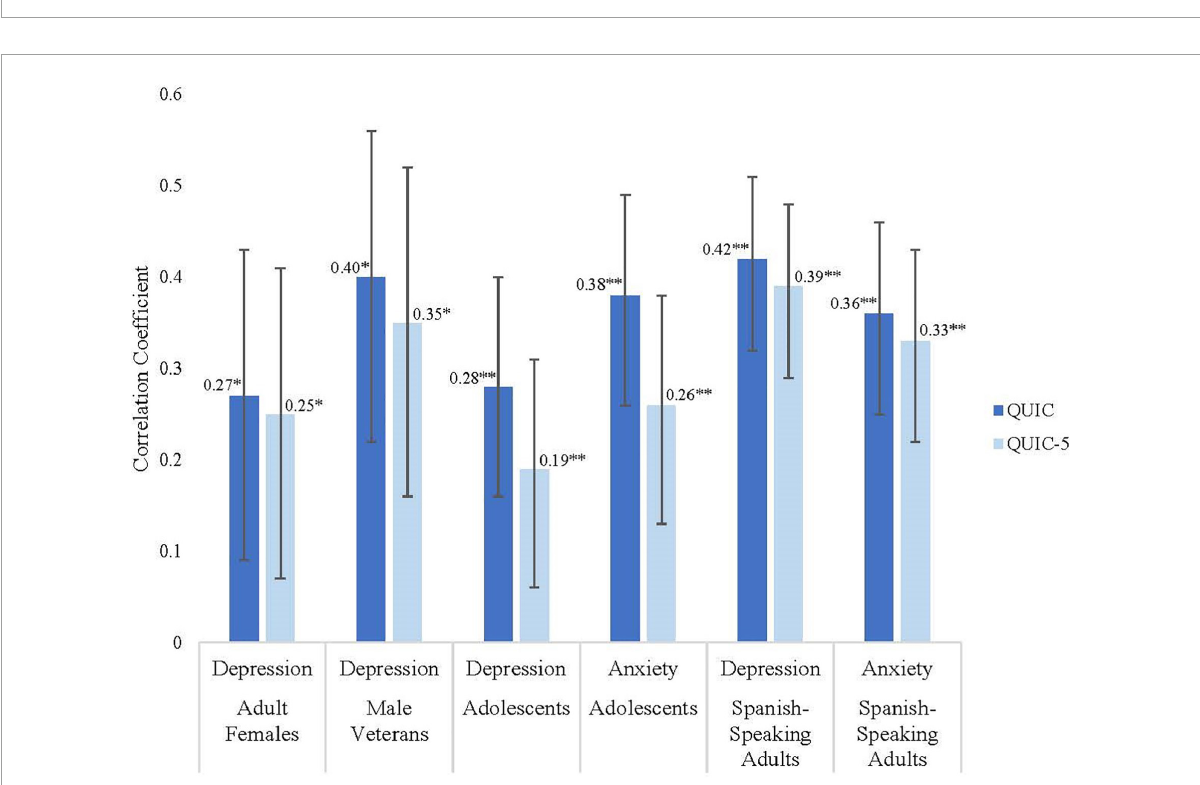
FIGURE2 Predictive validity for mental health outcomes of the QUIC-5 compared to the QUIC ( ∗ p < 0.05; ∗∗ p < 0.01). Dark bars indicate the size of the correlation coefficient for the 38-item QUIC, and the light bars are the correlation for the QUIC-5. Bars indicate 95% confidence